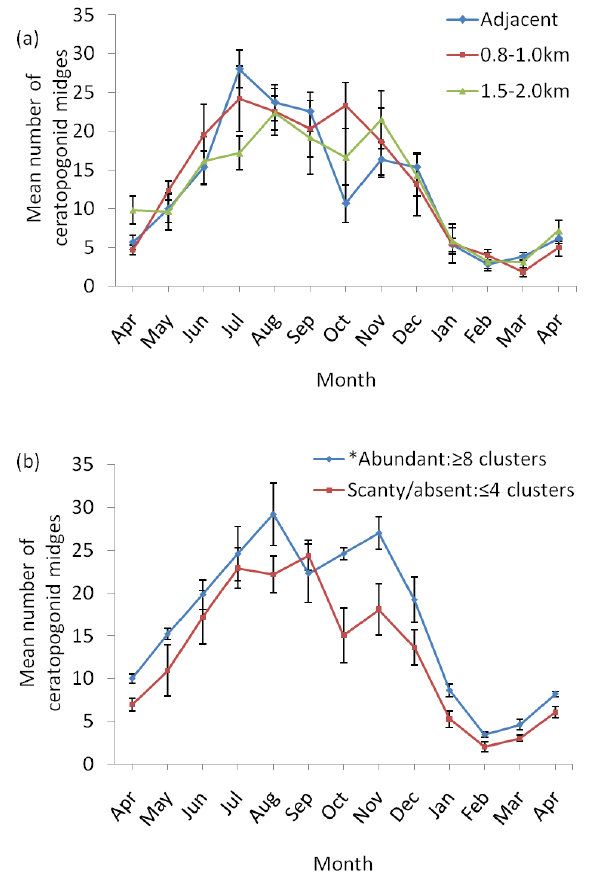
F IG . 3. Monthly population dynamics of ceratopogonid midges under: (a) Varying farm distance from natural forest. (b) Availability